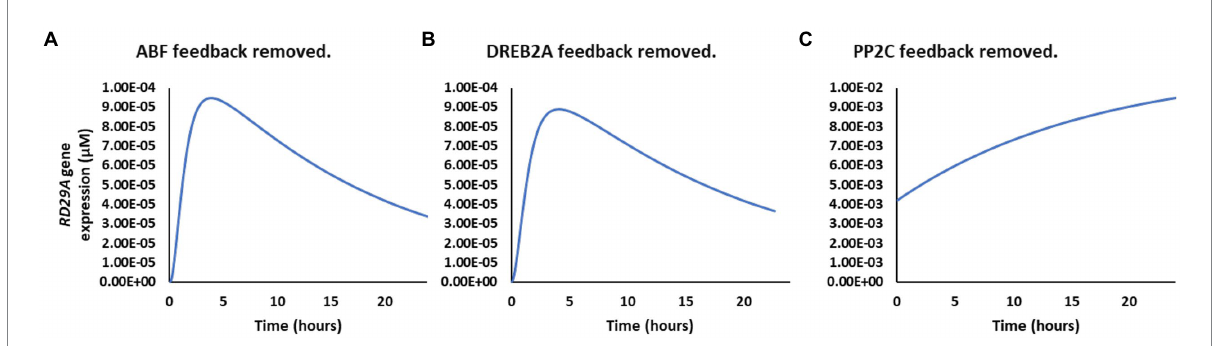
FIGURE 6 Effect of the different feedback loops on RD29A gene expression dynamics. (A) Without the ABF feedback loop. (B) Without the DREB2A feedback loop. (C) Without the PP2C feedback